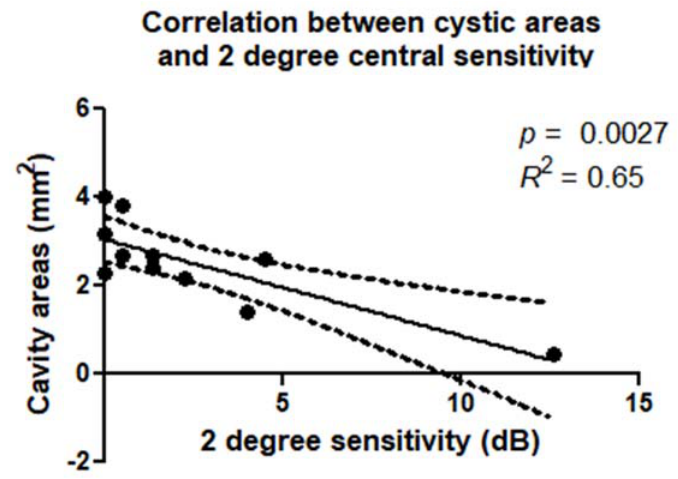
Figure 6. Scatterplot shows the statistically significant correlation ( p = 0.0027; R 2 = 0.65) between cavity areas in OPL + HFL complex (mm 2 ) and microperimetry 2 degree sensitivity (dB).